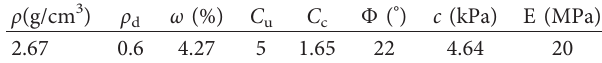
Table 2: Mechanical parameters of sand and